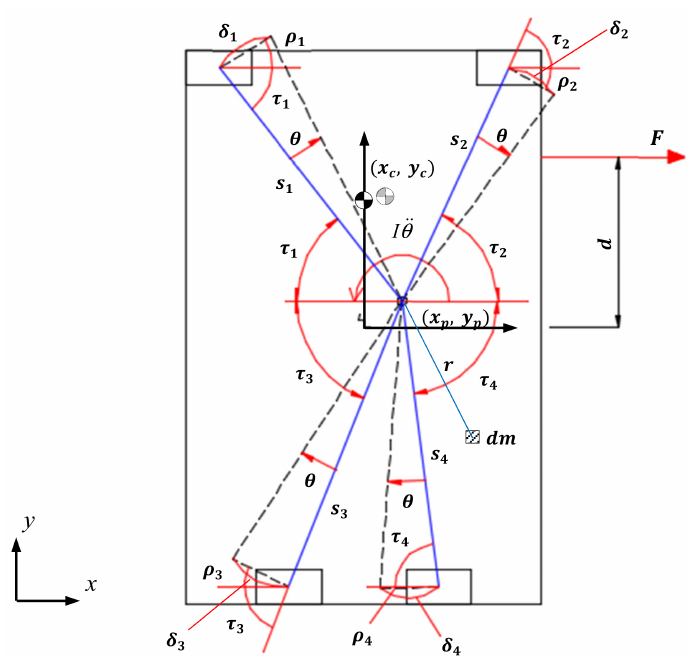
Figure 5. Schematic diagram of yaw